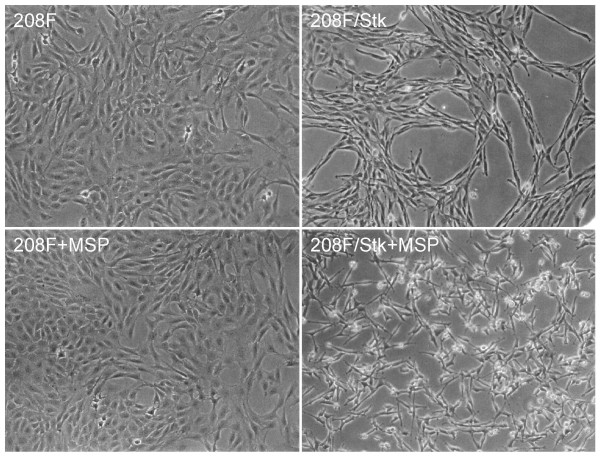
Scattering of 208F/Stk cells in response to MSP. 208F (left panels) and 208F/Stk c13 cells (right panels) were seeded at 2 × 104 cells per well in 24-well plates. Two days later the cells were treated overnight with 400 ng/ml MSP in growth medium (DMEM plus 10% FBS) (bottom panels) or with medium alone (top panels) and were photographed.